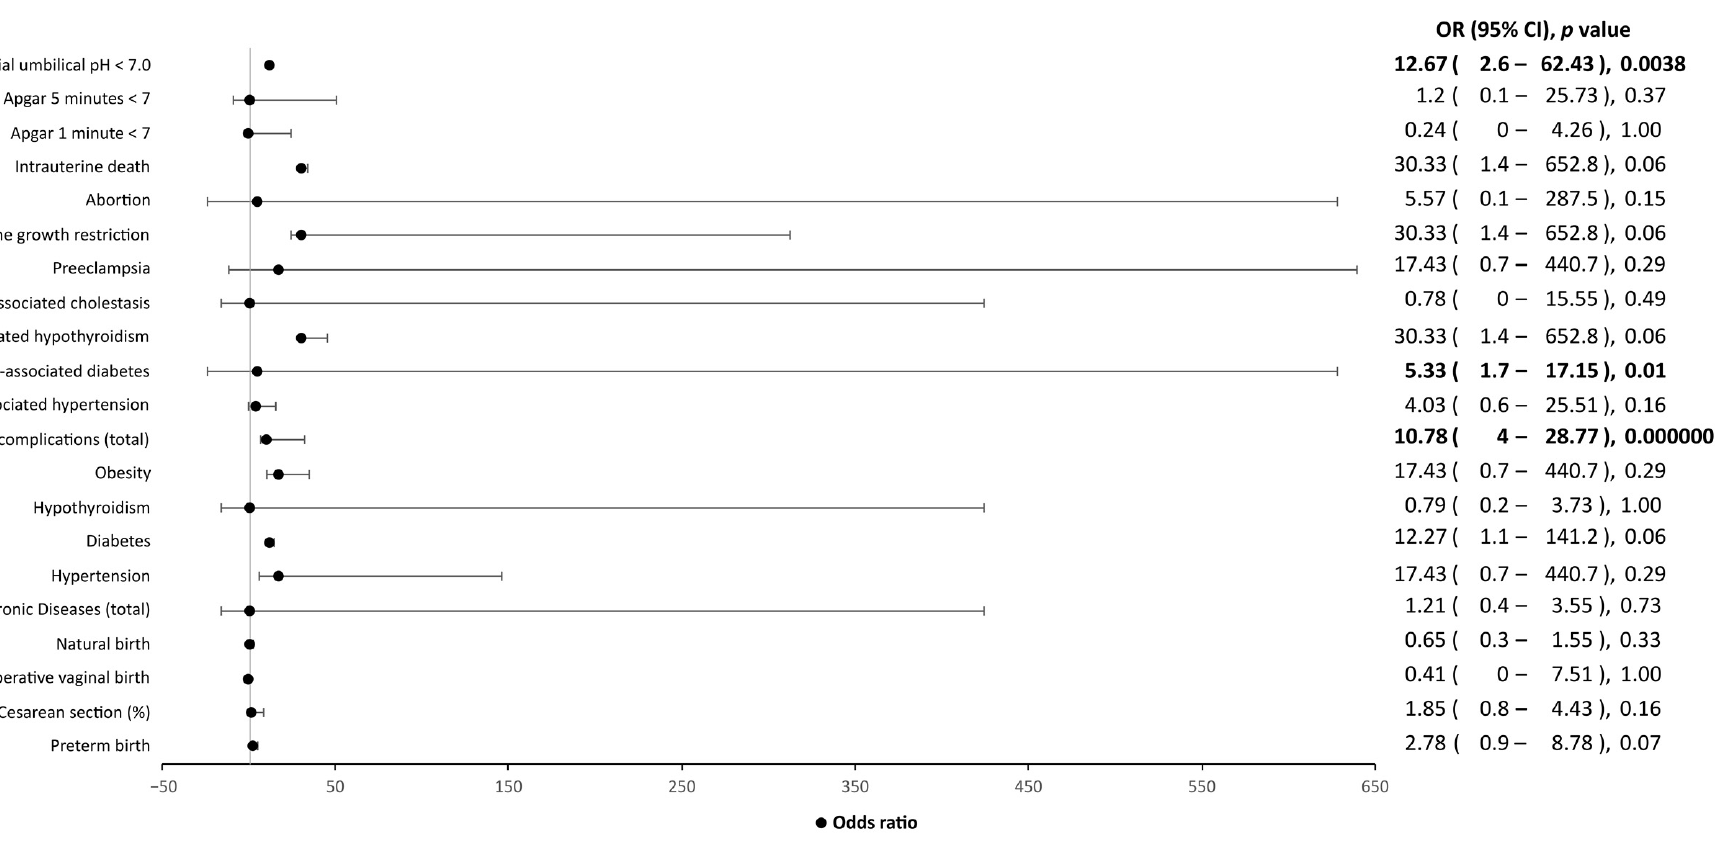
Figure 3. Influence of clinical factors, including chronic diseases, pregnancy-associated complications, and Apgar score, on symptomatic SARS-CoV-2-positive mothers and their children, as compared to SARS-CoV-2-negative mothers and their children. OR, odds ratio; CI, confidence interval. Values in bold indicate statistical significance, as the level of statistical significance was set to p < 0.05.